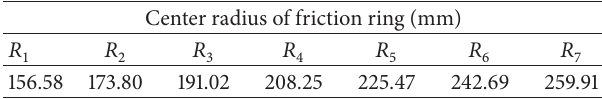
Table 5: Center radius of friction rings.